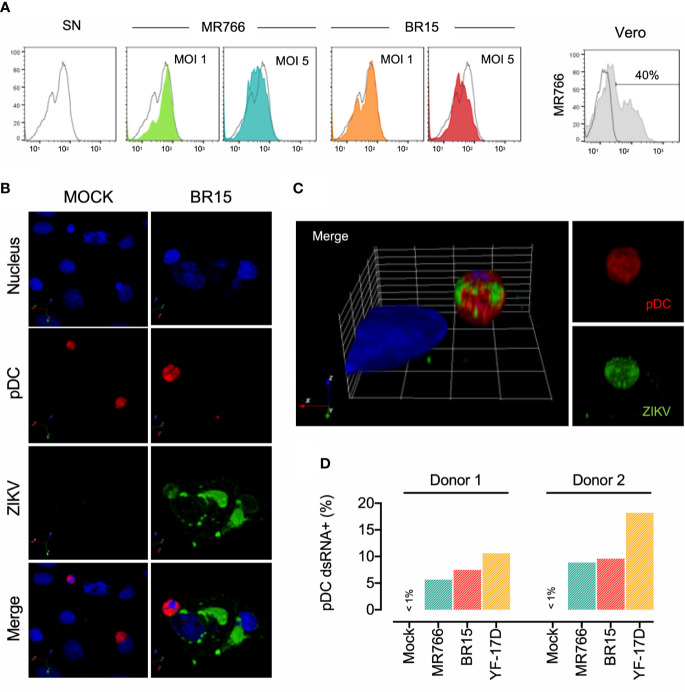
Susceptibility of pDC to ZIKV infection (A) ZIKV envelope protein expression in pDCs after 24 h of exposure to the virus. Histograms show 4G2 staining of pDCs exposed to virus-free supernatant (SN) as negative control, ZIKV MR766 or BR15 at MOI of 1 or 5 (colored histograms) and infected Vero cells (grey histogram). In this last histogram, dotted line corresponds to mock-infected Vero cells. The percentage of Vero cells expressing 4G2 is indicated. (B) Confocal microscopy analysis of pDCs exposed 24 h to virus-free supernatant (SN) or Vero cells infected with ZIKV BR15 at a MOI of 1. Cell nucleus was stained with NucBlue, pDCs were stained with the cell tracker Deep Red before their coculture with Vero cells, and ZIKV was detected intracellularly with the mouse polyclonal antibody (20), which recognizes Env and NS1 proteins. (C) 3D reconstitution of confocal microscopy acquisition of ZIKV-BR15 infected pDC. pDCs were labelled in red, the nucleus in blue, and ZIKV in green. Images are representative of three independent experiments conducted with primary cells from three distinct donors. (D) Frequency of pDCs infected by ZIKV. pDCs were cocultured 24 h with Vero cells uninfected (mock) or infected with ZIKV MR766 or BR15, or with YF-17D. The frequency of infected pDCs was determined following the intracellular staining with J2 anti-dsRNA antibody. Experiments performed with sorted pDCs from two distinct donors are shown.